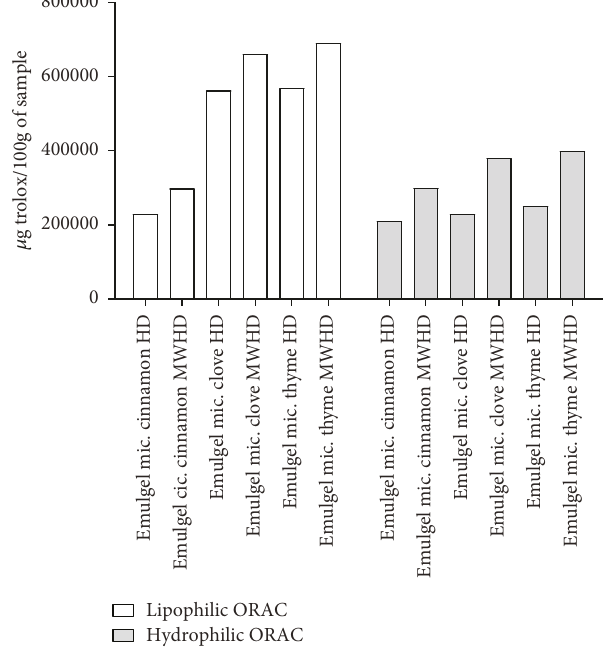
Figure 18: Antioxidant activity of EO microcapsule emulgels determined by the hydrophilic and lipophilic ORAC